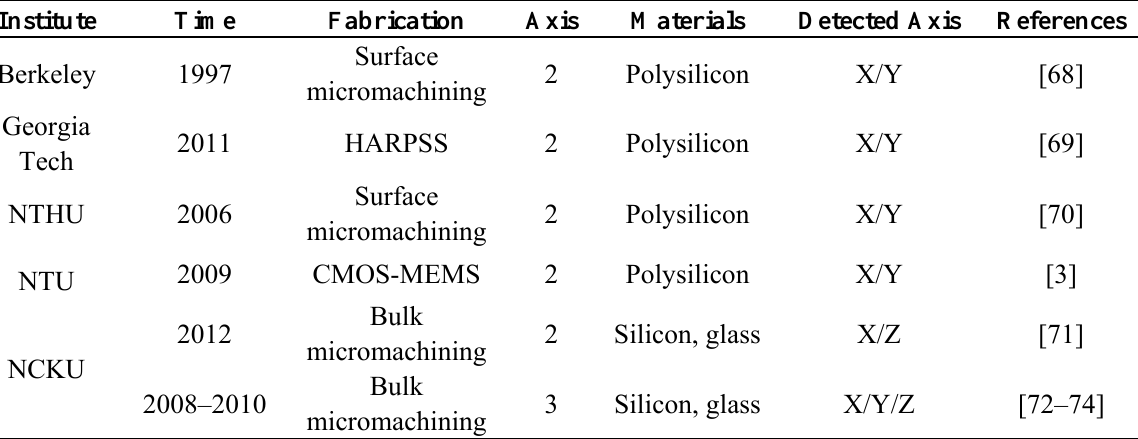
Table 7. The summary of multi-axis